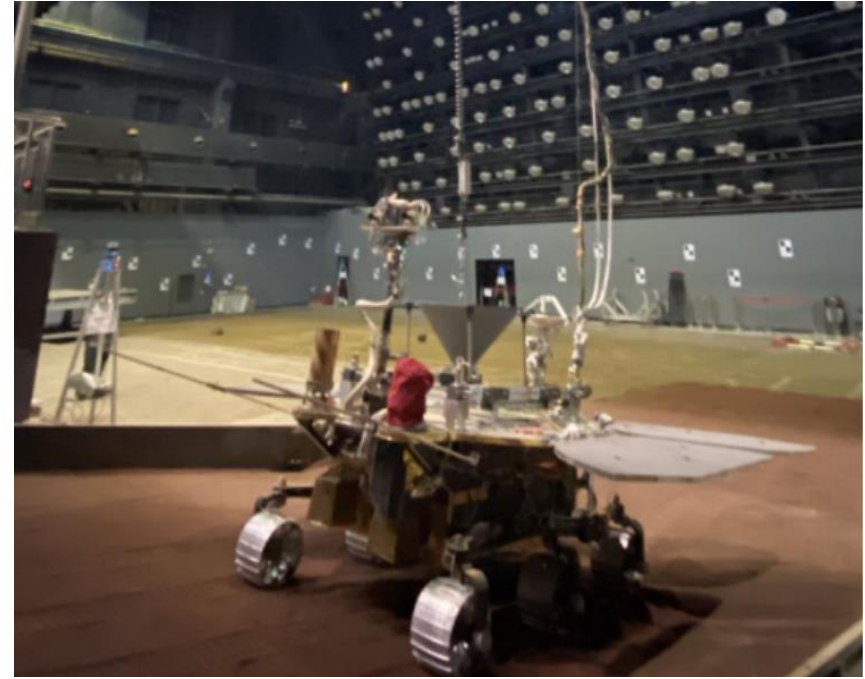
Figure 2. The indoor test site of ground tests.